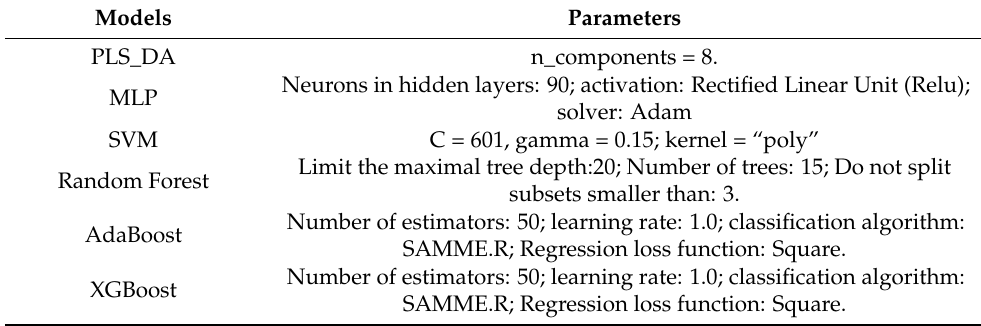
Table 2. Details of the parameterization used to adjust each final classification model.